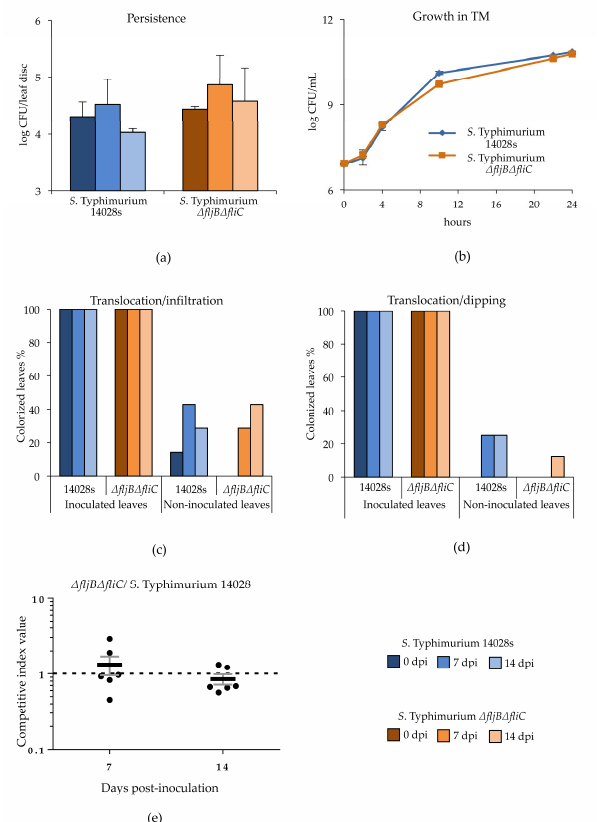
Figure 1. Salmonella persistence in and on leaves does not require flagella. Salmonella enterica serovar Typhimurium strain 14028s ( S . Typhimurium 14028s) and the double S . Typhimurium ∆ fljB ∆ fliC mutant were infiltrated at OD 600 nm = 0.01 (ca. 10 7 CFU / mL) into tomato leaves. The presence of viable colony forming units (CFUs) was assessed during the following 14 days in cutout leaf discs. Both Salmonella strains persisted at the same level after infiltration ( a ). To monitor Salmonella growth in tomato-based (TM) medium, the number of CFU of S . Typhimurium 14028s and the double mutant S . Typhimurium ∆ fljB ∆ fliC was assessed during 24 h post inoculation (hpi) into TM ( b ). Both strains reached the steady state during the 24 h, no di ff erence between the wild type and the mutant proliferation rates was observed. Translocation of bacteria to non-inoculated leaves was verified using two inoculation techniques: infiltration ( c ) and dipping ( d ). After inoculation of leaves with bacterial suspensions (10 7 CFU / mL for infiltration or 10 8 CFU / mL for dipping), leaves were cut at the indicated days post inoculation (dpi) and subsequently incubated in enrichment media Bu ff ered Peptone Water (BPW) and Rappaport Vassiliadis Broth (RVS). Graphs represent the translocation e ffi ciency after infiltration ( c ) or dipping ( d ) inoculation. The enrichment cultures in RVS medium were plated on XLD-agar medium. The bars represent the percentage of plants for which non-inoculated leaves were positive for Salmonella from an average of seven (infiltration) and eight (dipping) replicates (one leaf per plant per treatment). ( e ) Direct comparison between persistence of S . Typhimurium 14028s and the double mutant S . Typhimurium ∆ fljB ∆ fliC was assessed using competitive index (CI) assays. Both strains were co-inoculated by infiltrating a 5 × 10 5 CFU / mL with a 1:1 proportion of these two strains. Bacteria were extracted 7 and 14 dpi from tomato leaves and plated on LB plates for CFU determination. Replica plating was carried out in LB and LB plus kanamycin to di ff erentiate between the two strains. CIs presented are representative results from six replicates. Mean CI values are shown. Errors bars represent standard error. Each CI was analyzed using a homoscedastic and 2-tailed Student’s t -test and the null hypothesis that mean index is not significantly di ff erent from 1, p < 0.05 were considered